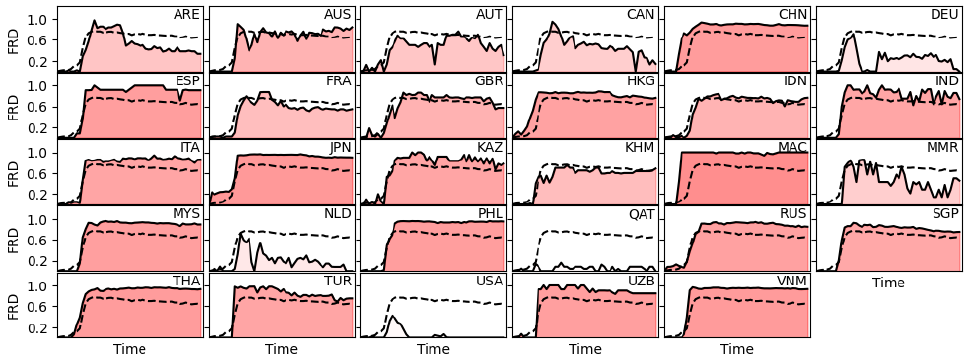
Figure 3. Comparison of flight ratio discrepancy for all countries pairs involving South Korea; each subplot corresponds to one destination country. The dashed line represents the average flight ratio discrepancy for South